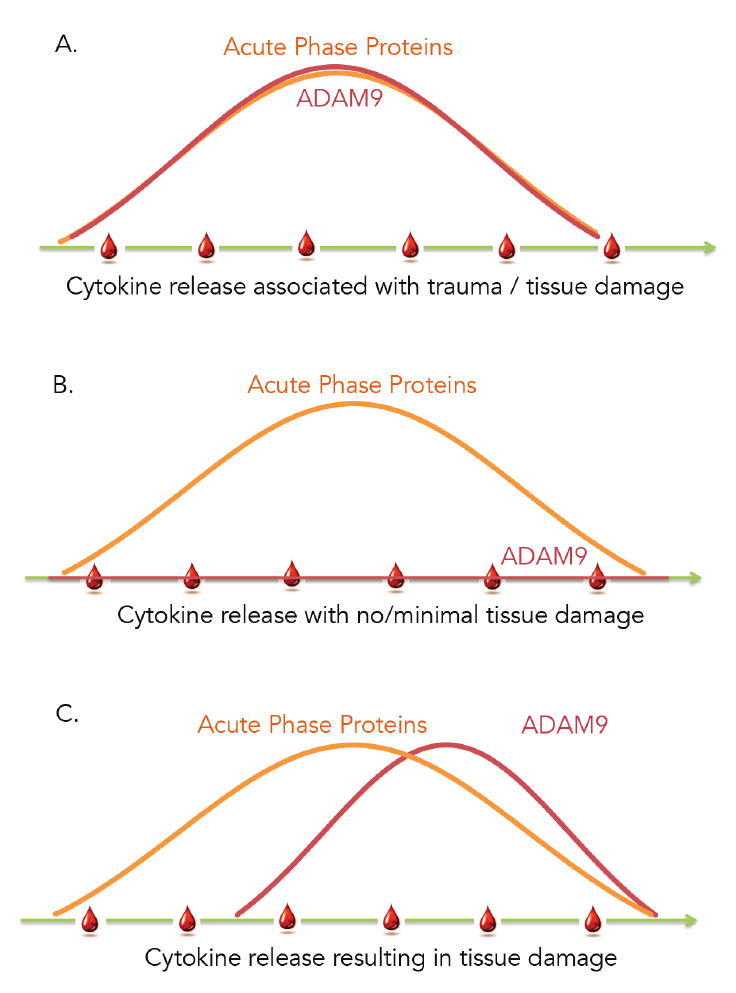
Figure 6. Proposed Model. A . Sterile inflammation resulting from tissue injury caused for instance by severe trauma, surgery or radiation therapy can be monitored via the use of prototypical markers of inflammation (acute phase proteins) with ADAM9 levels increasing in concert. B . Acute infection also causes a measurable inflammatory response that is the direct result of the antimicrobial response mounted by the immune system. This response can develop in absence of substantial tissue injury and thus does not cause an increase in abundance of ADAM9. C . When substantial tissue injury occurs as a result of the infection the abundance of ADAM9 rises, which detection enables the identification and triage of critically ill